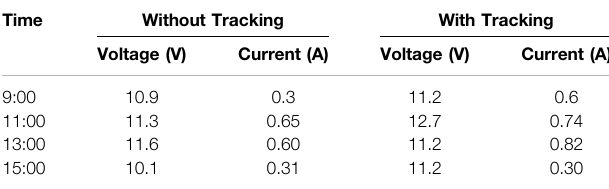
TABLE 2 | Voltage and current values without and with tracking.